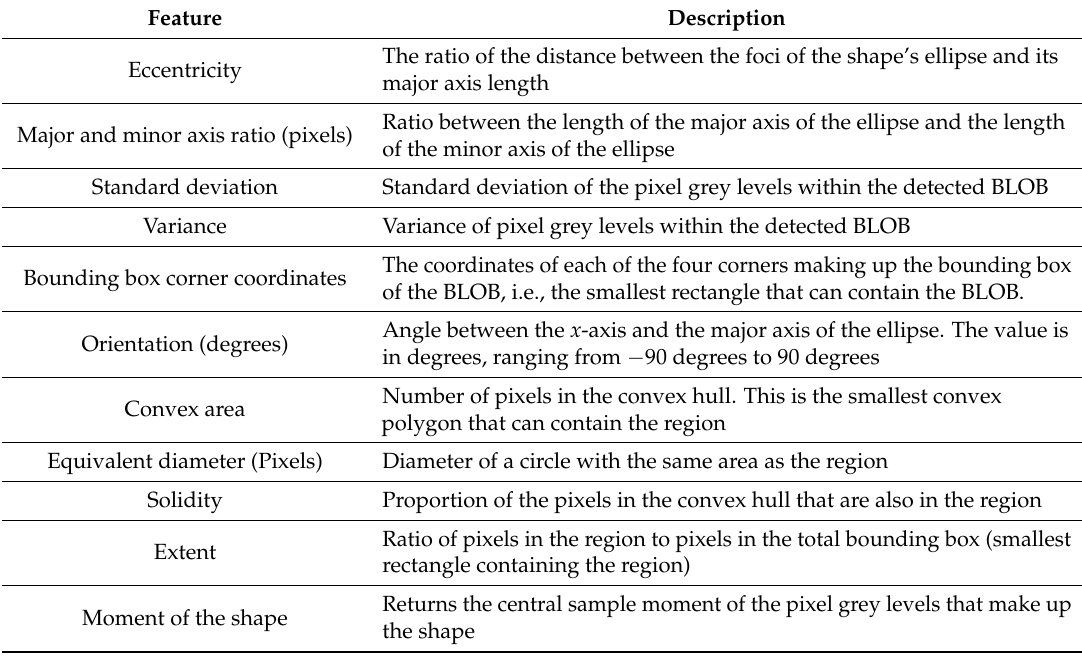
Table 1. Features collected from each of the two TIS